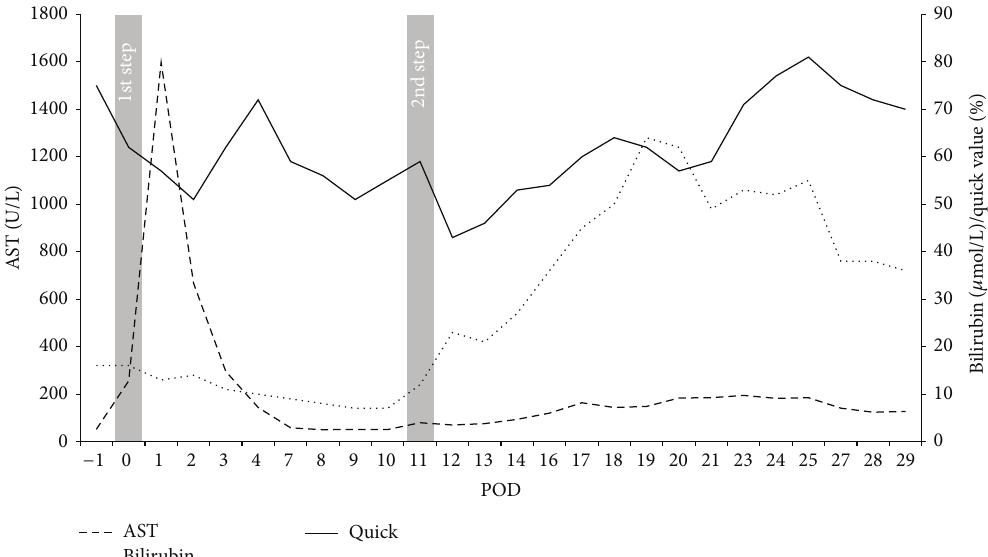
Figure2:PostoperativecourseofAST,Bilirubin,andQuickvalue.DiagramdepictingthecoursesofAST,Bilirubin,andQuickvaluefollowing the first and second step of the ALPPS-procedure,